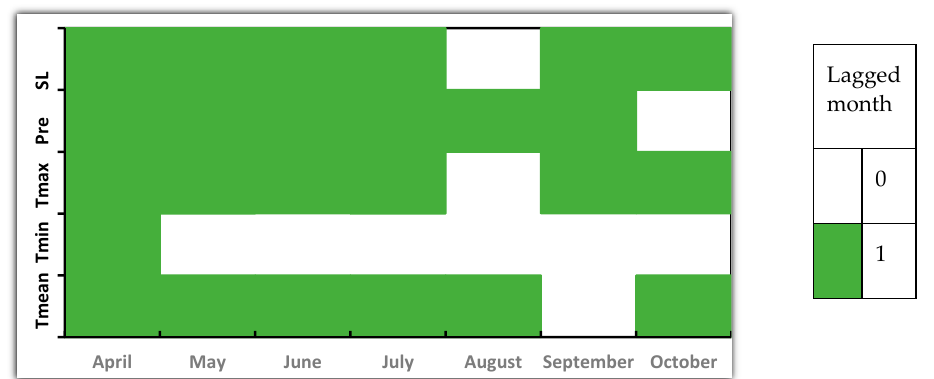
Figure 6. The lag month between tea NDVI and climatic factors within growing season from 2009 to 2018.